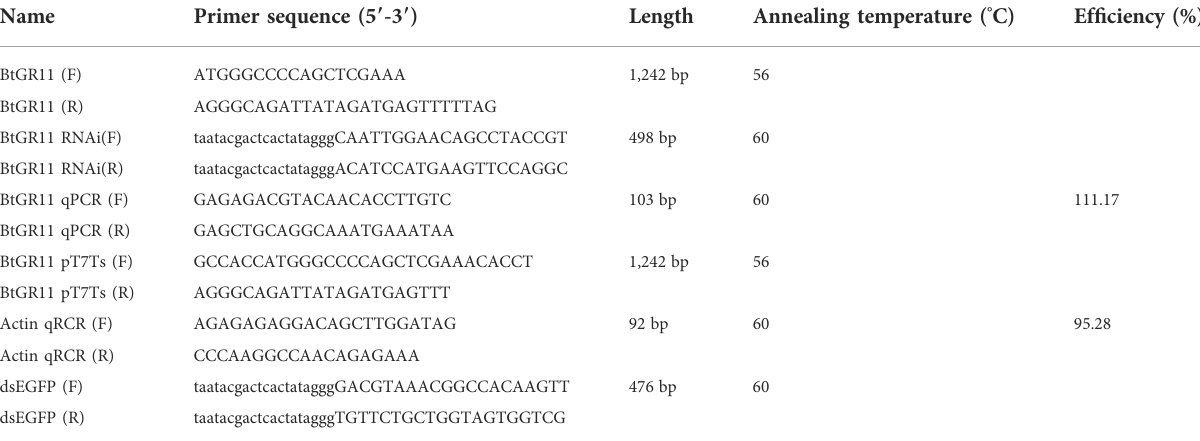
TABLE 1 List of primers designed and annealing temperatures used in this